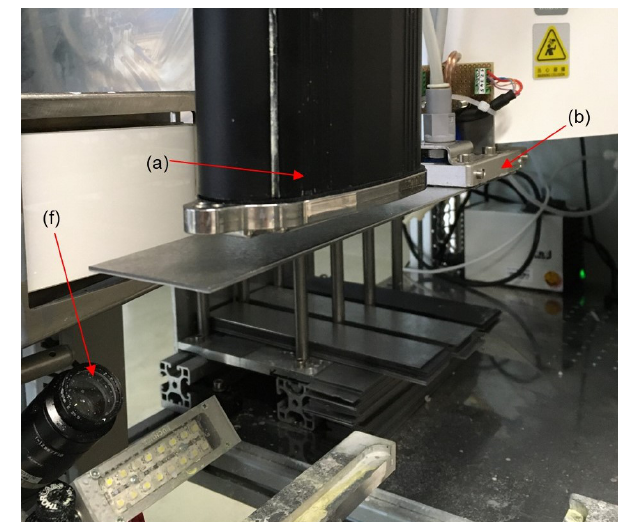
Figure 3. A detailed photograph of the test bench showing the printhead (a) with a metal sheet that is moved underneath the printhead by the robot (b) . Additionally, the camera observing ink residues on the printhead is visible (f)